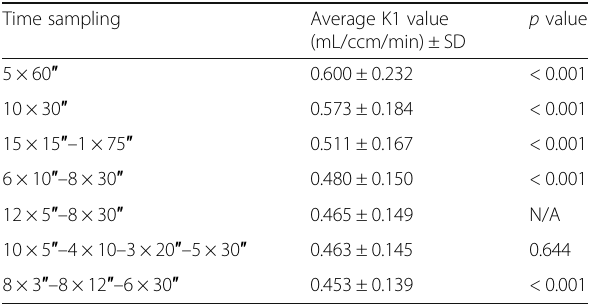
Table 2 Comparison of the K1 values from the optimal time sampling (12 × 5 ″ -8 × 30 ″ ) and K1 values from the other time samplings for clinical validation